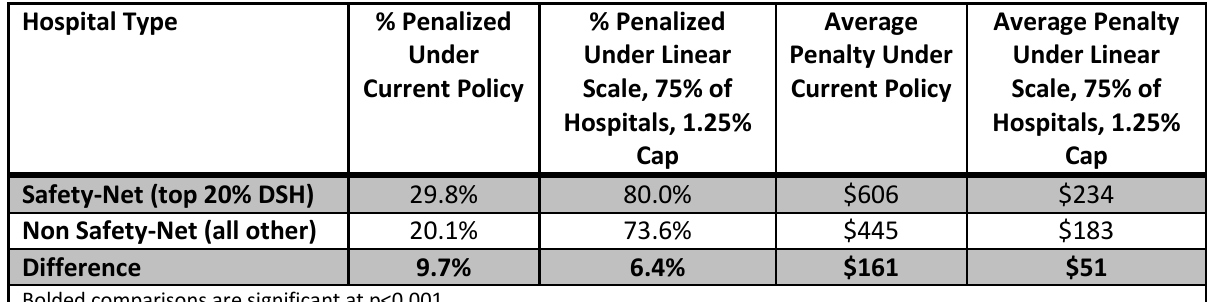
Table 6.21: Penalties Under Linear Scale with 75% of Hospitals Penalized, Penalties Capped at 1.25%